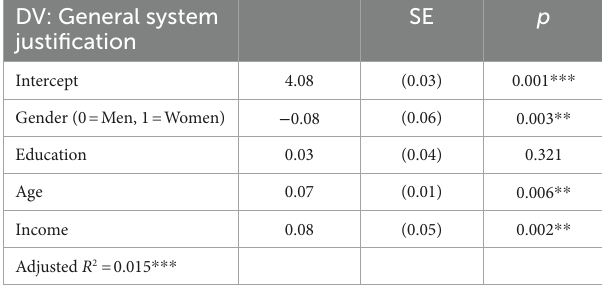
TABLE 3 Results of multiple regression analysis (DV: GSJ).